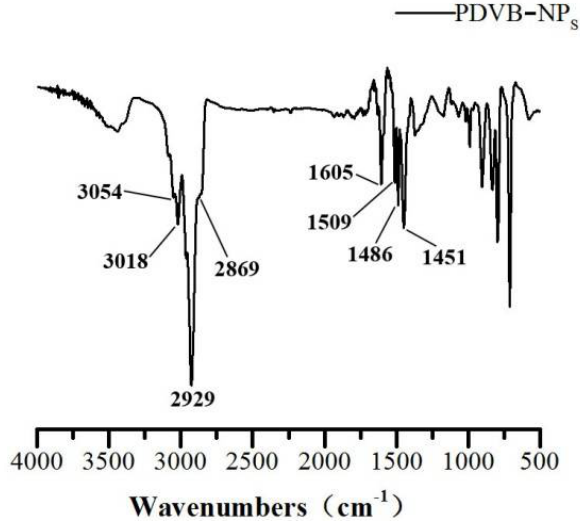
Figure 1. FTIR spectra of PDVB-NP S .